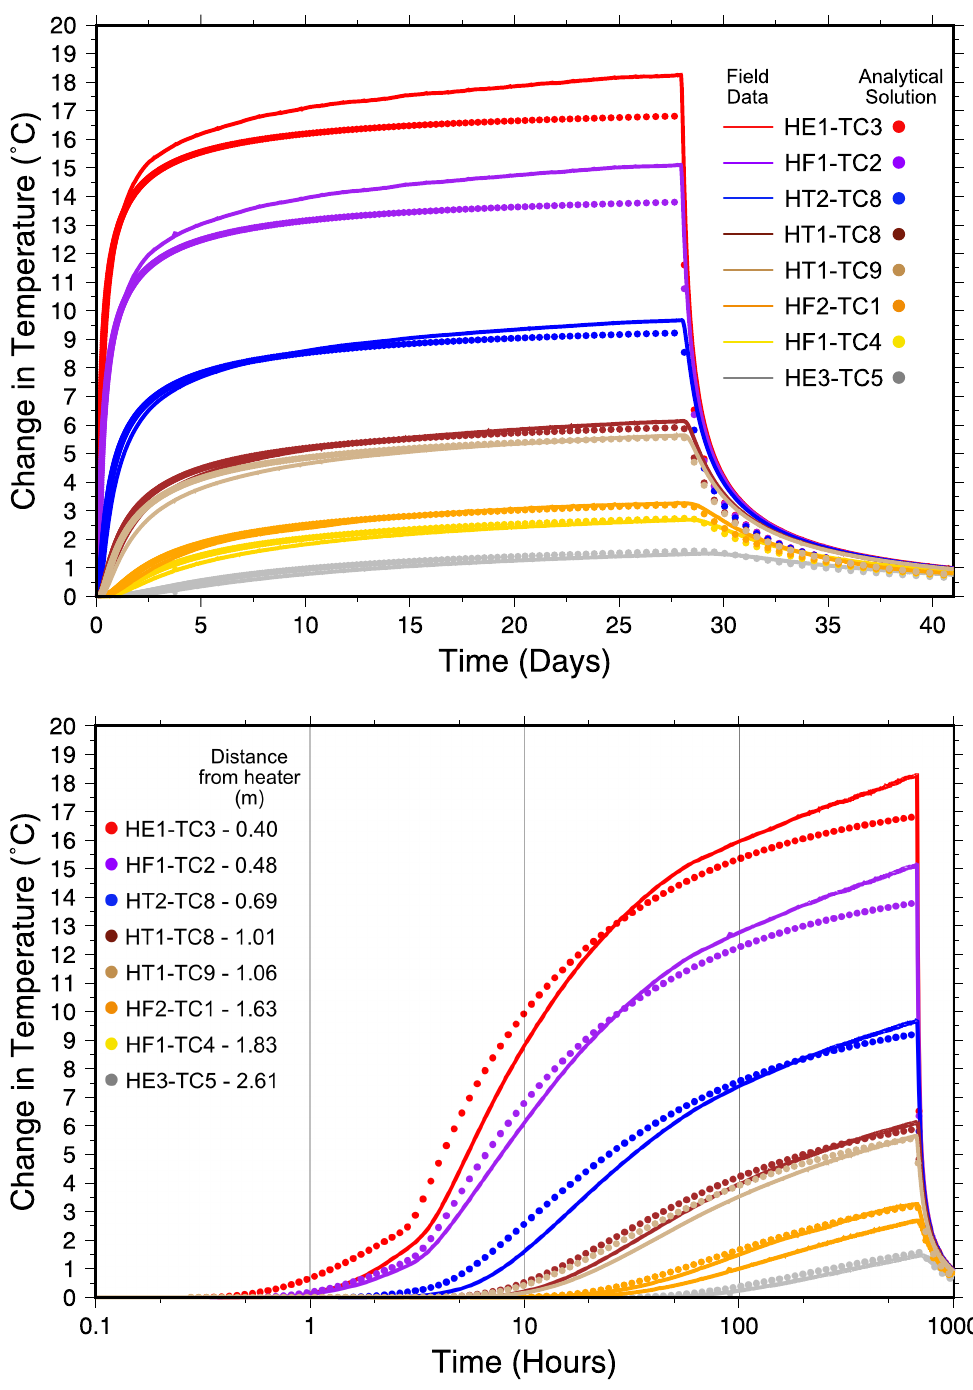
Figure 8. Analytical solution for best fit parameters at 8 thermocouples. The top panel shows the predicted temperature at each thermocouple in linear time and the bottom panel shows the temperature fits in log-time. The field data are denoted by solid lines and the modeled temperature are the corresponding colored